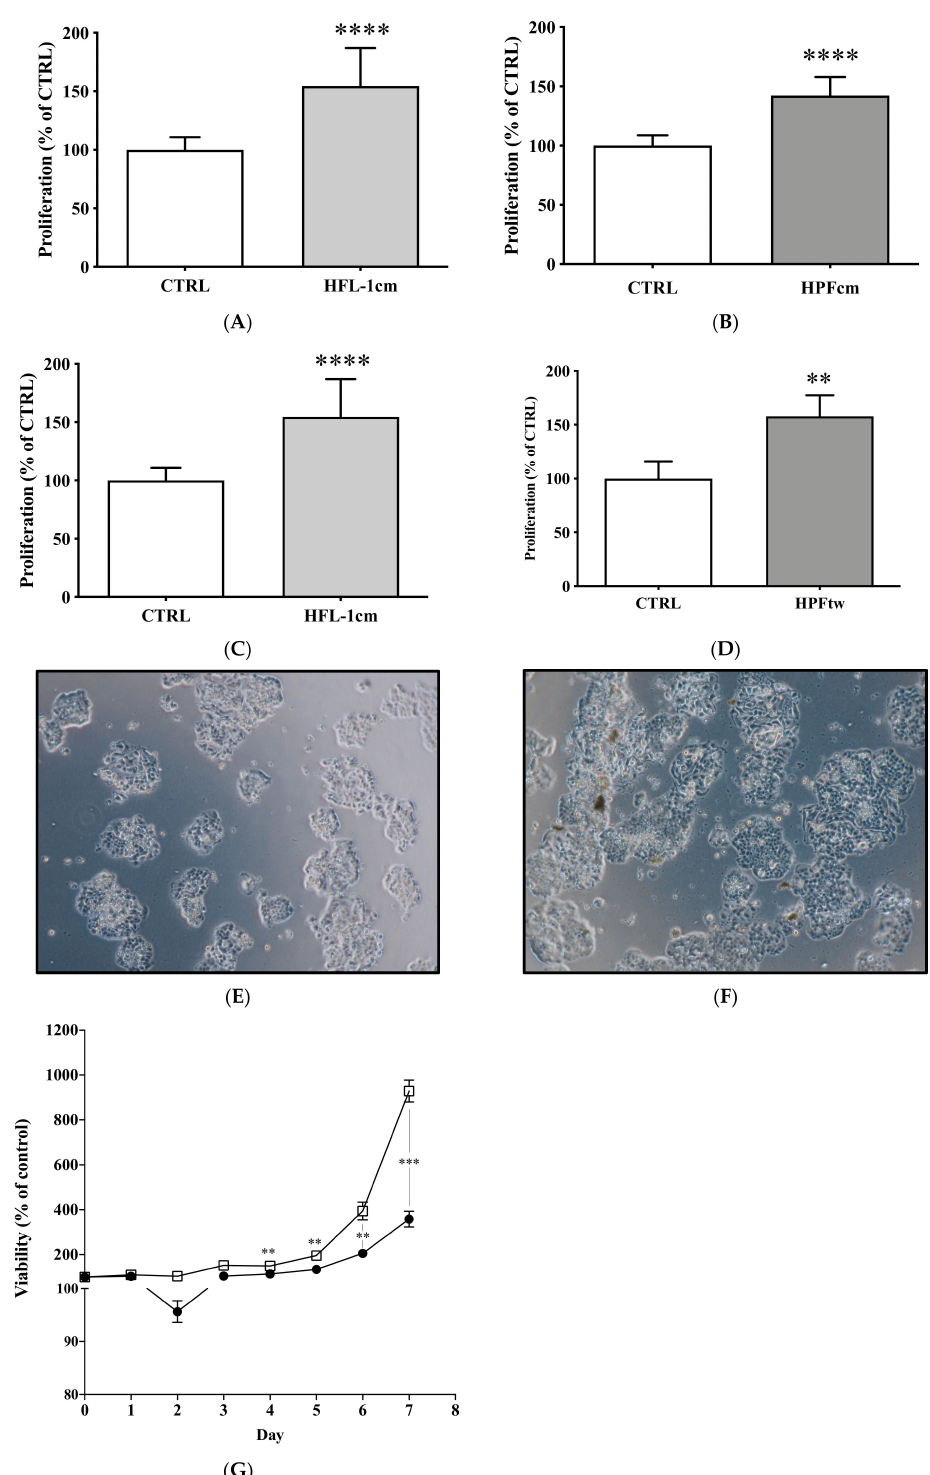
Figure 3. Impact of human fibroblasts on the proliferation of QGP-1 cells. Incubation of QGP-1 with either HFL-1-conditioned medium ( A ) or HPF-conditioned medium ( B ) resulted in a significant increase in proliferation compared to controls. Similar results were observed when QGP-1 was co- cultured with either HFL-1 ( C ) or HPF ( D ) cells in transwell experiments. ( E ) Picture taken of QGP-1 cells in control situation. Note the increased density of the cell layer when QGP-1 was incubated with the HPFcm ( F ). ( G ) Cellular viability of QGP-1 cells in the presence ( (cid:3) ) of HPFcm as compared to control ( • ) over a 7 day period. **** p < 0.0001; *** p < 0.001; ** p <